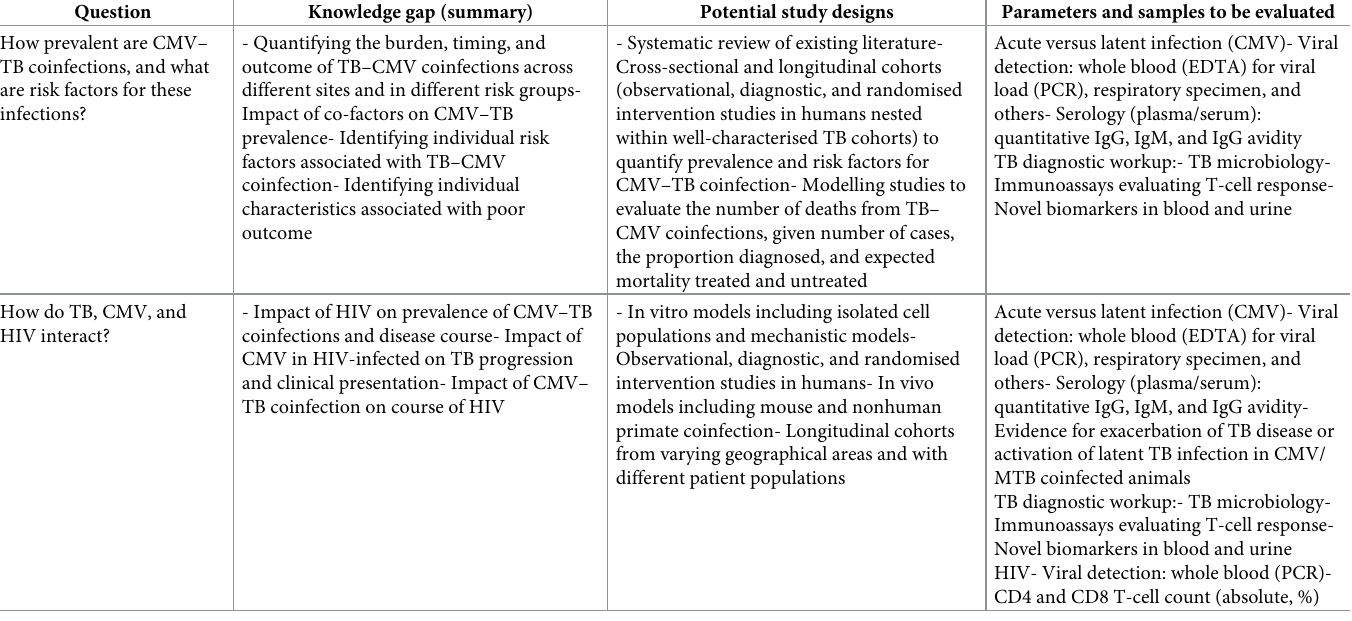
Table 2. Understanding the burden for CMV–TB